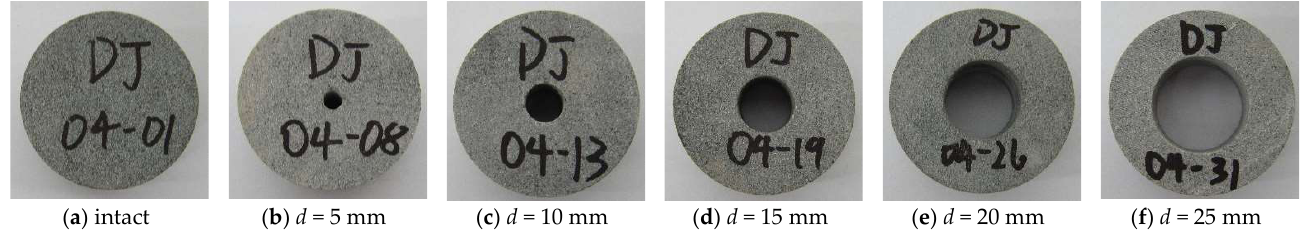
Figure 1. Processed annular sandstone specimen.